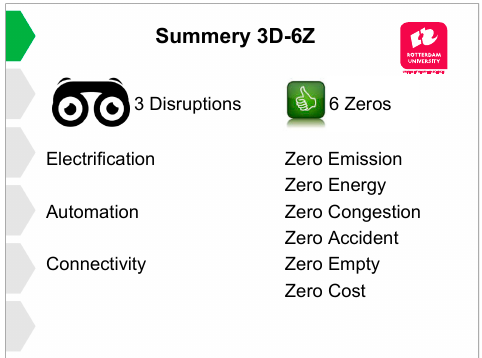
Figure 7. Three technology disruptions and the Six Zeros . Reproduced with permission from Rotterdam University of Applied Sciences, the Netherlands.